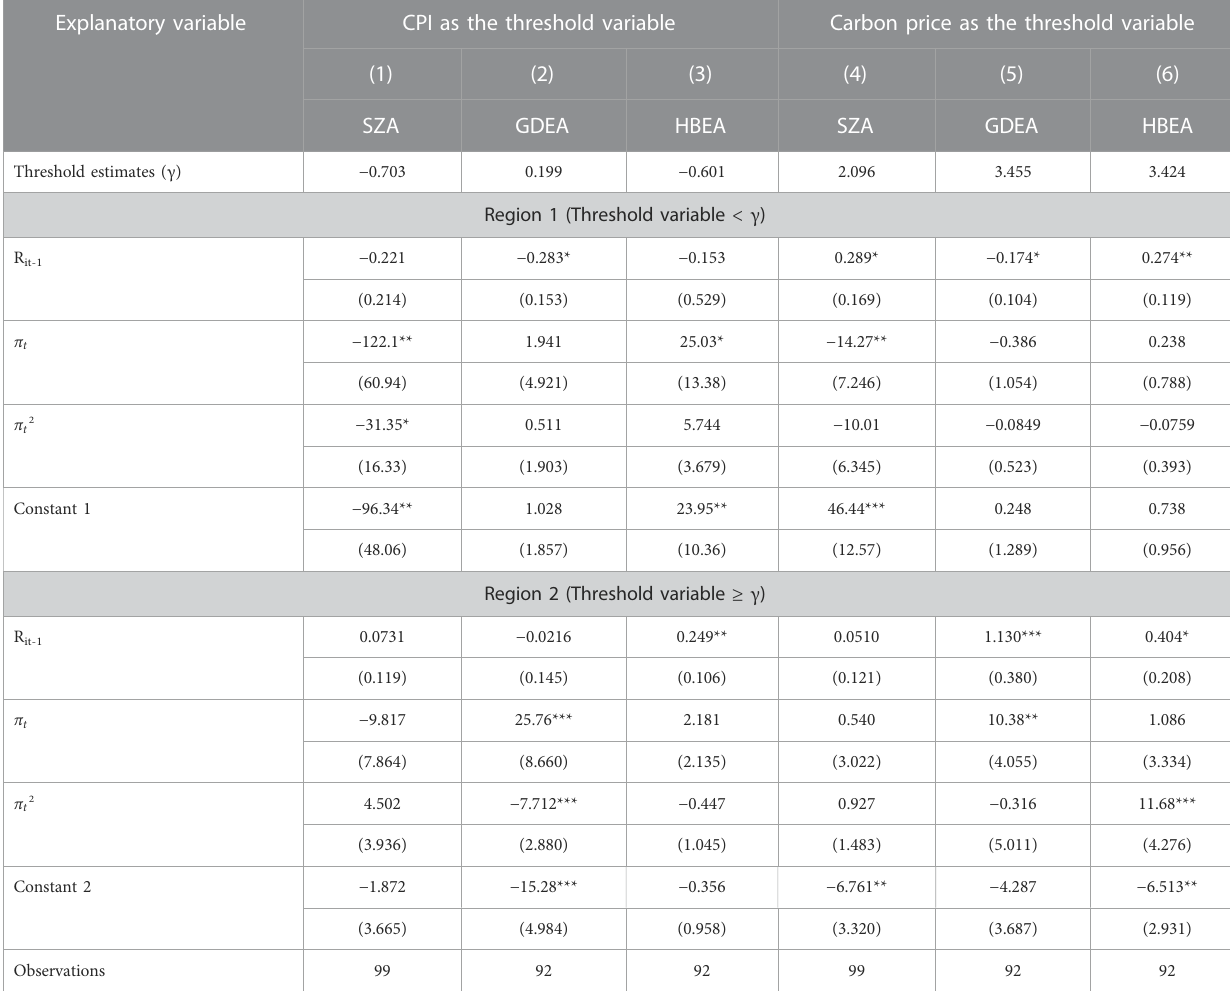
TABLE 5 Threshold regression results of carbon price growth rate and in fl ation square term. Explanatory variable